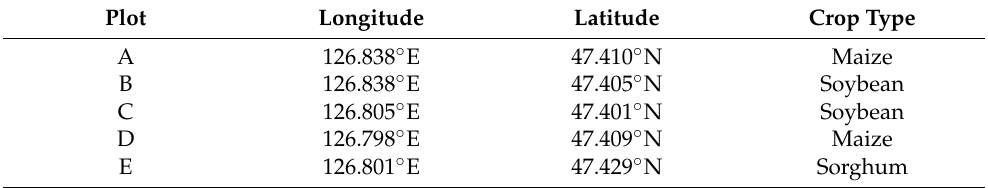
Table 1. Locations and crop types of the plots in the study area for field LAI measurements [29]. Plot Longitude